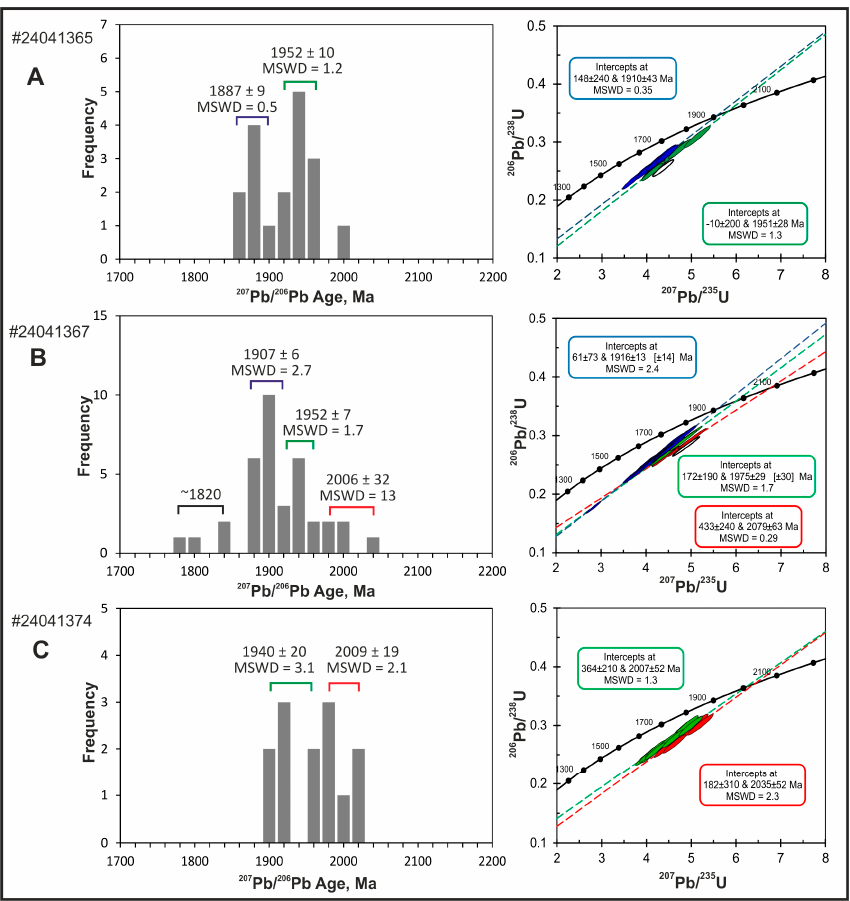
Figure 5. Frequency distribution diagrams for 207 Pb/ 206 Pb ages and Wetherill concordia diagrams for Type 2 uraninite in different samples. Black ellipses on the Wetherill diagrams mark data which were excluded from the regression of discordia lines. Minerals 2017 , 7 , 171 15 of 23